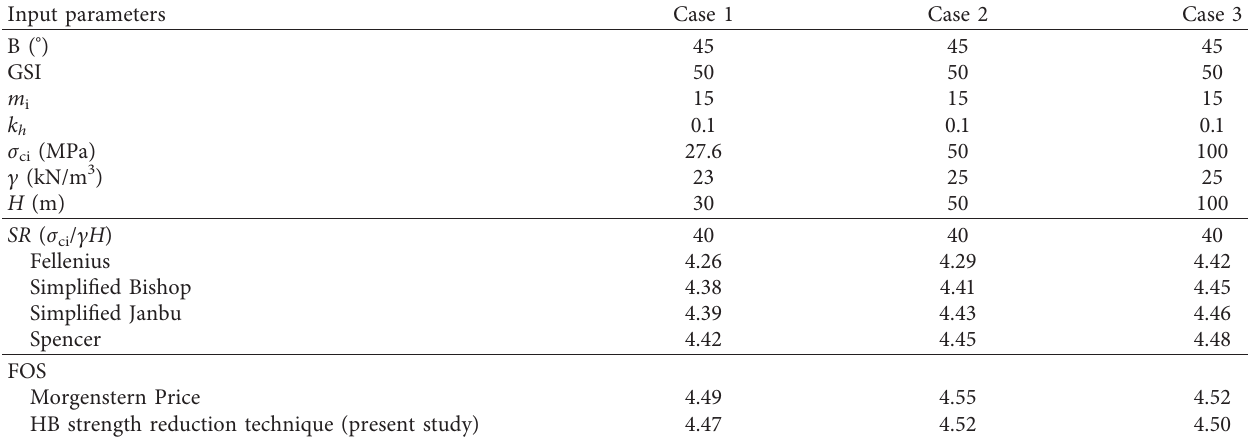
Table 1: Comparison of the FOS for a given slope with the same values of SR.